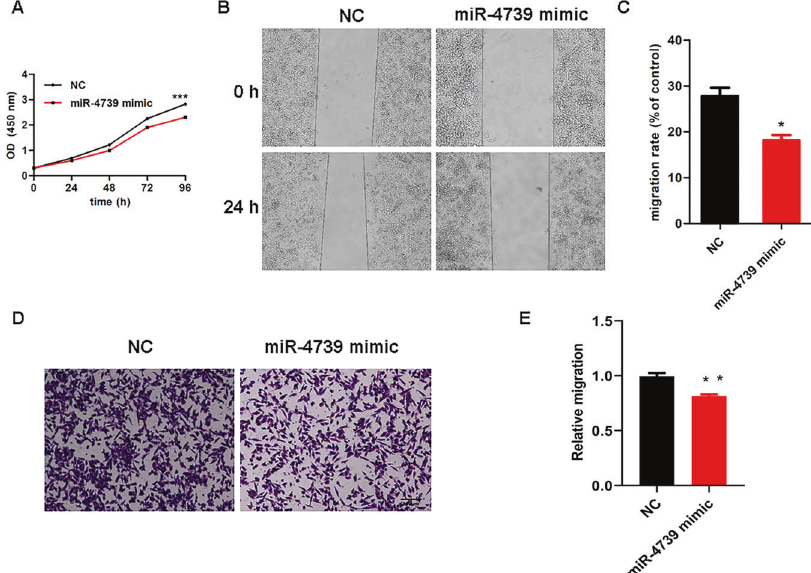
Fig. 7 Enhanced expression of miR-4739 inhibits cell growth and development in vitro. A CCK-8 assay revealed that overexpression of miR- 4739 depressed cell proliferation. B, C Wound healing assay showed that upregulation of miR-4739 expression prohibited metastasis. D, E Augmentation of miR-4739 expression decreased metastasis in the Transwell assay. Data are presented as the mean ± SD. All data were evaluated according to three independent experiments. * p < 0.05, ** p < 0.01 and *** p < 0.001.